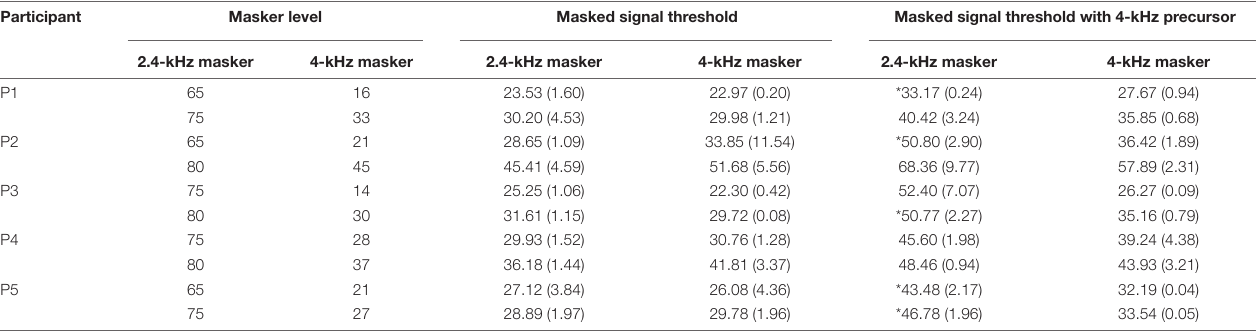
TABLE 1 | Individual data with equally effective